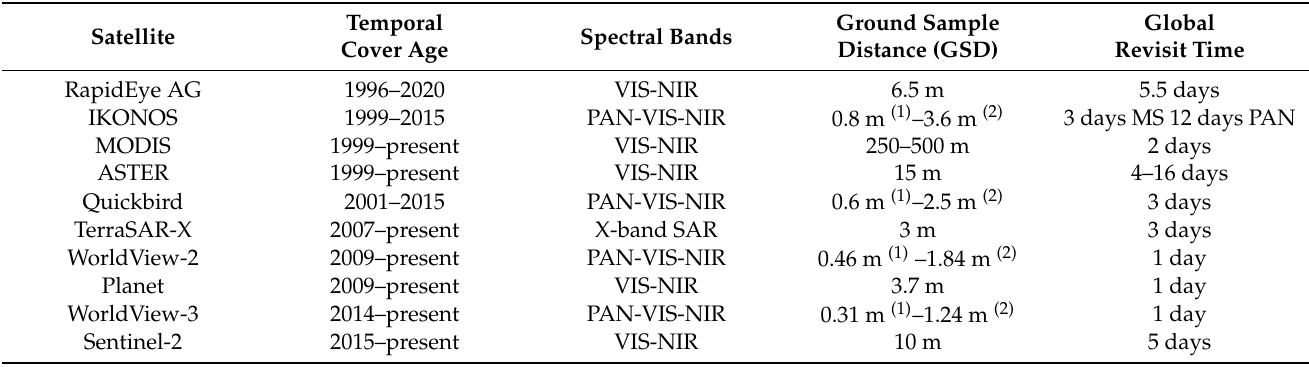
Table 1. Representation of satellites used for viticulture surveys. Subscript (1) indicates the GSD for PAN bands, while subscript (2) indicates the GSD for Multispectral